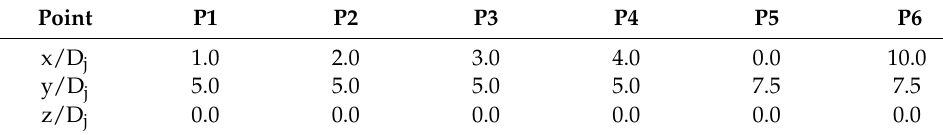
Table 2. Point Locations of Pressure Data Probes for CLST